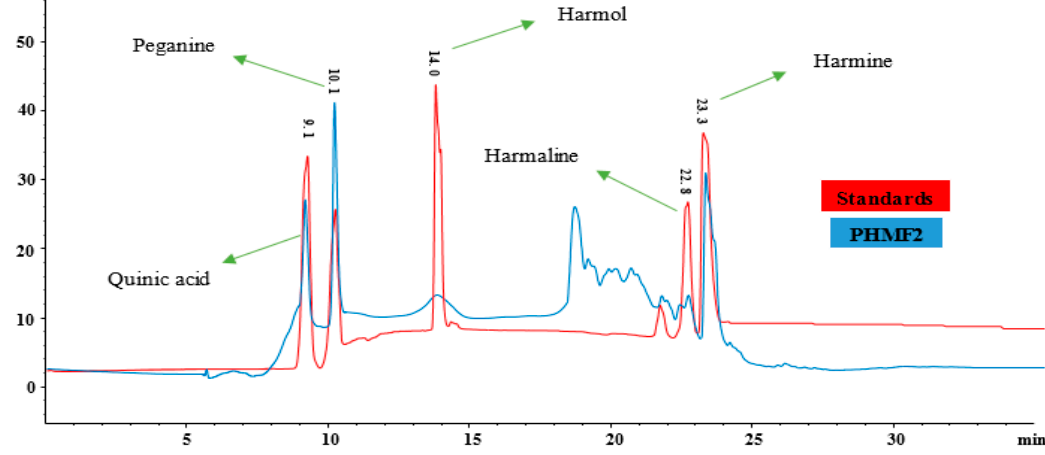
Figure 9. HPLC overlay chromatogram of the mixture of external standards and PHMF2 at 280 nm.